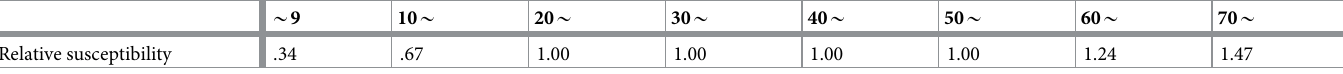
Table 2. Age-dependent